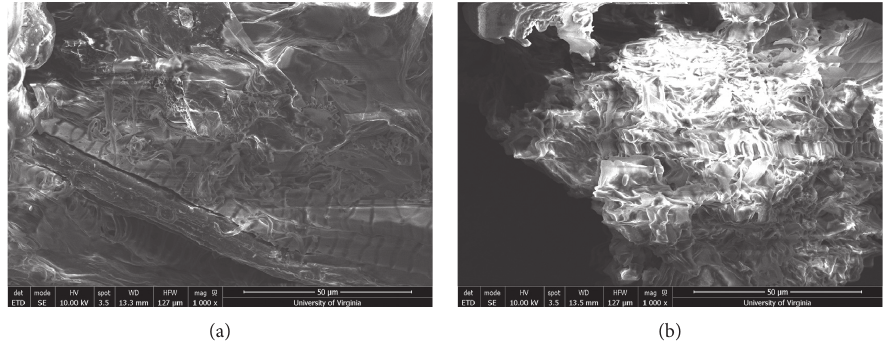
Figure 1: SEM micrograph of (a) GBL sorbent and (b) MB loaded GB sorbent with more homogenous surface.